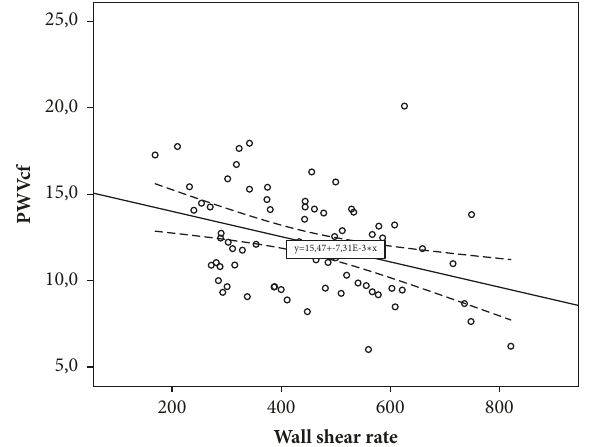
Figure 4: The relationship between wall shear rate and carotid- femoral pulse wave